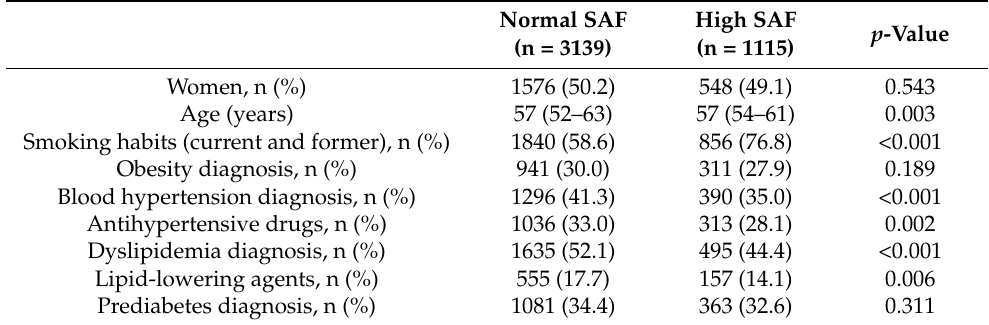
Table 1. Central clinical and metabolic data in the ILERVAS cohort according to skin autofluorescence